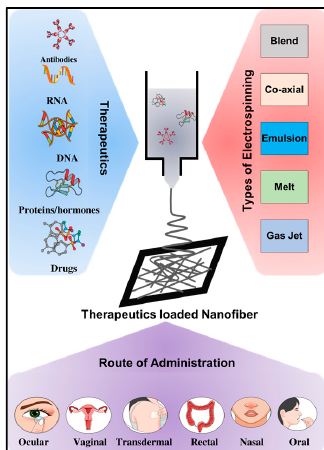
Figure 2. Types of electrospinning, different therapeutics-loaded nanofibers and their route of administrations.